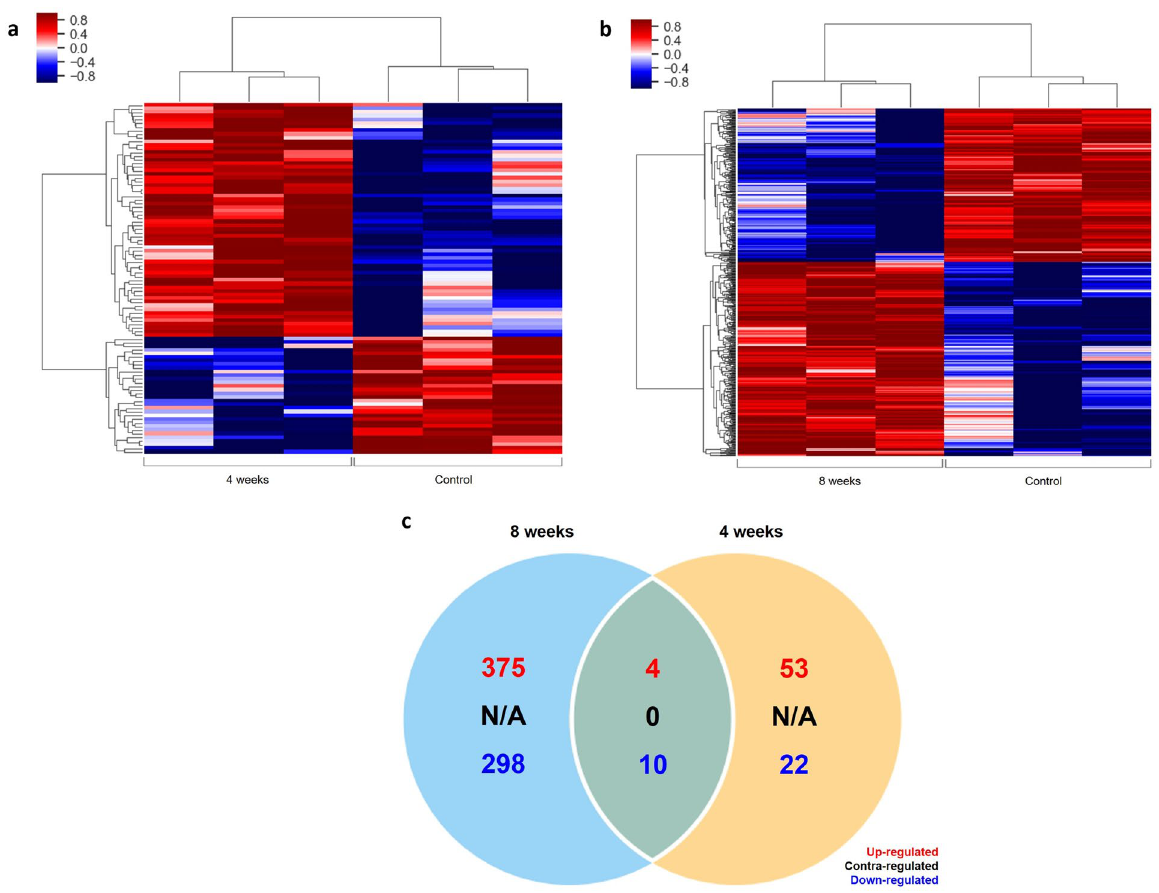
Figure 4. Analysis of PHMG-regulated gene expression in rat lung tissue. Heatmaps of PHMG regulated genes at 4 and 8 weeks post-PHMG exposure (frames a and b ). A Venn diagram shows the numbers of genes that were up-regulated, contra-regulated, and down-regulated between 4 and 8 weeks after PHMG exposure (frame c